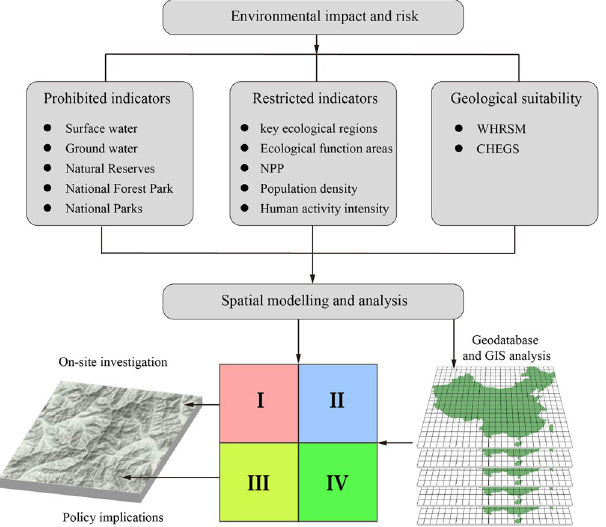
Figure 2. Schematic diagram for environment optimization based site selection for CO 2 geological storage. Note: WHRSM, Institute of Rock and Soil Mechanics, Chinese Academy of Sciences; CHEGS, China Geological Survey Center for Hydrogeology and Environmental Geology Survey. Four categories of suitability for CO 2 geological storage include I and II, III and IV with increasing suitability. The map in this figure were generated by software ArcGIS 9.2 (http://www.esri.com/arcgis/about-arcgis) based on our own data. The China spatial boundary GIS data is from the National Geomatics Center of China (affiliated with National Administration of Surveying, Mapping and Geoinformation of China), which provides the basic GIS data for China.